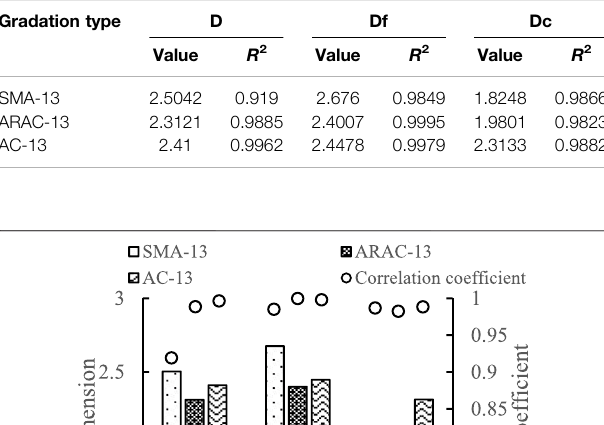
Frontiers in Materials |